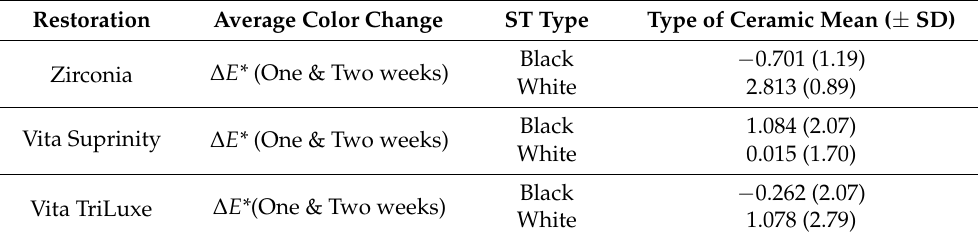
Table 3. ∆ E * between ceramic materials, time intervals, and type of ST.